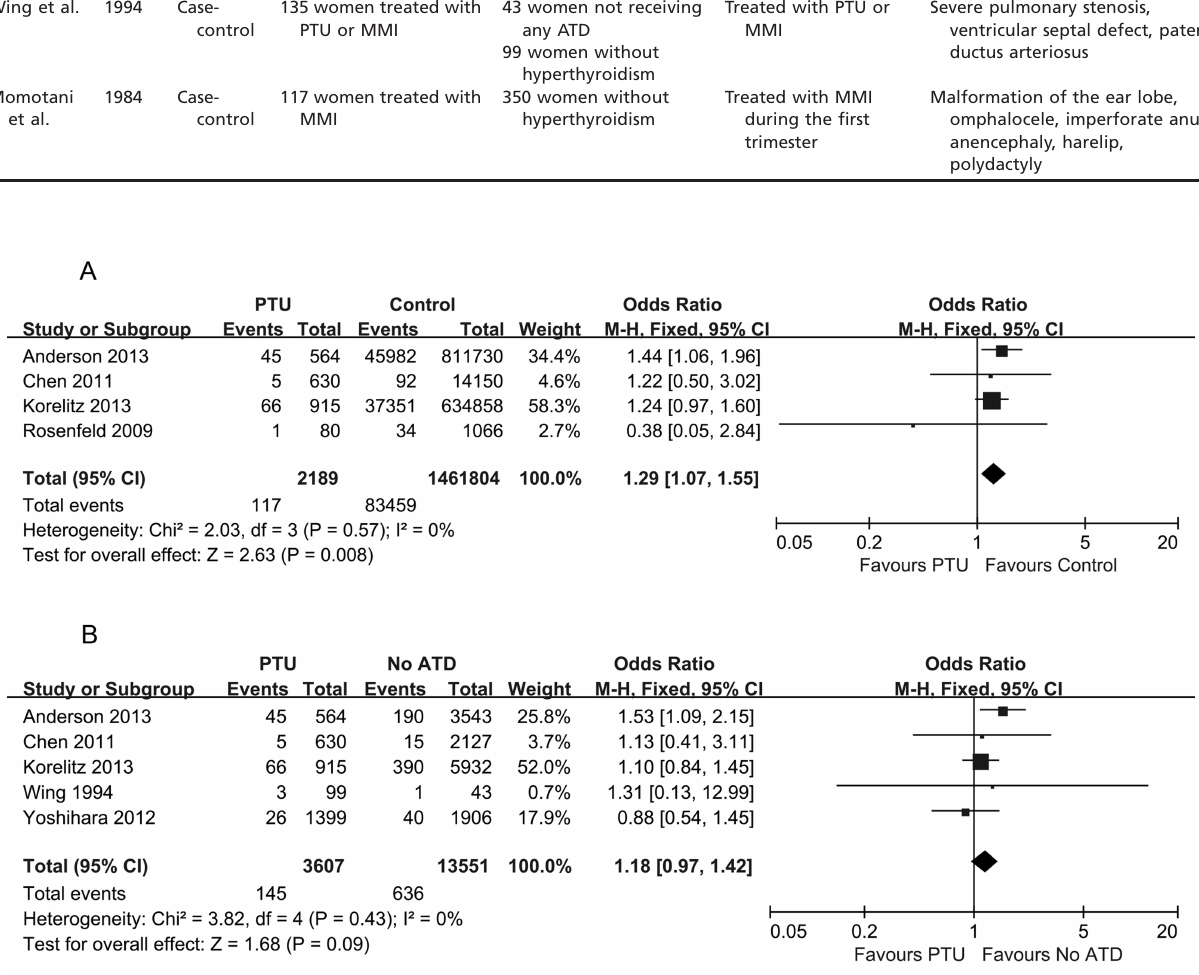
Figure 2 - Forest plot of the odds ratios and 95% confidence intervals of the pooled studies. (A) PTU-treated pregnant hyperthyroid women compared with healthy pregnant women according to the risk of congenital anomalies. (B) PTU-treated pregnant hyperthyroid women compared with pregnant hyperthyroid women not receiving any ATD treatment according to the risk of congenital